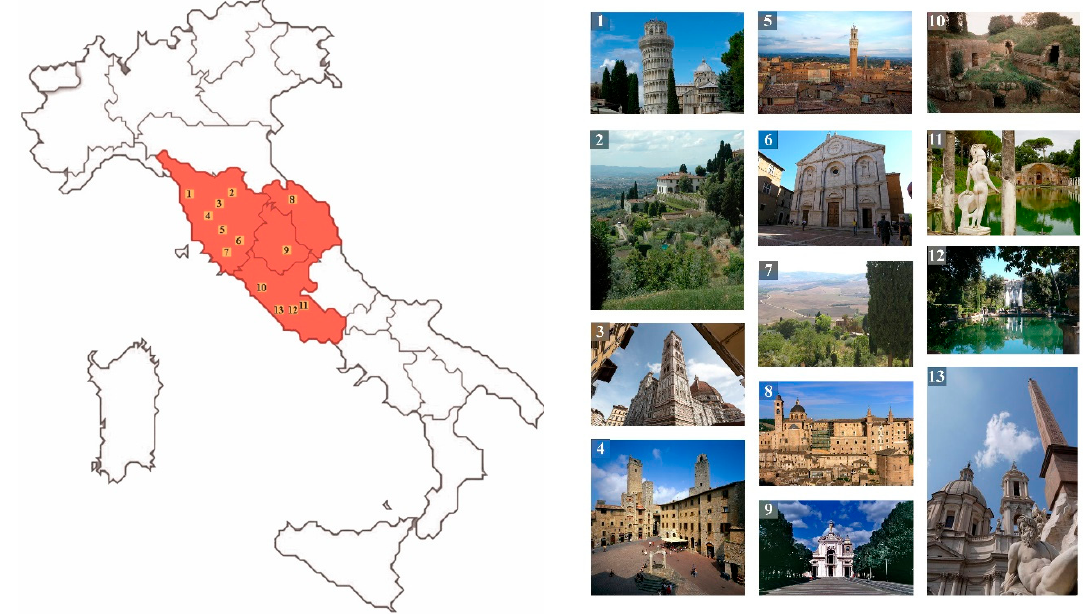
Figure 1. World heritage sites in Central Italy [42]. Table 1. World Heritage Sites in Central Italy